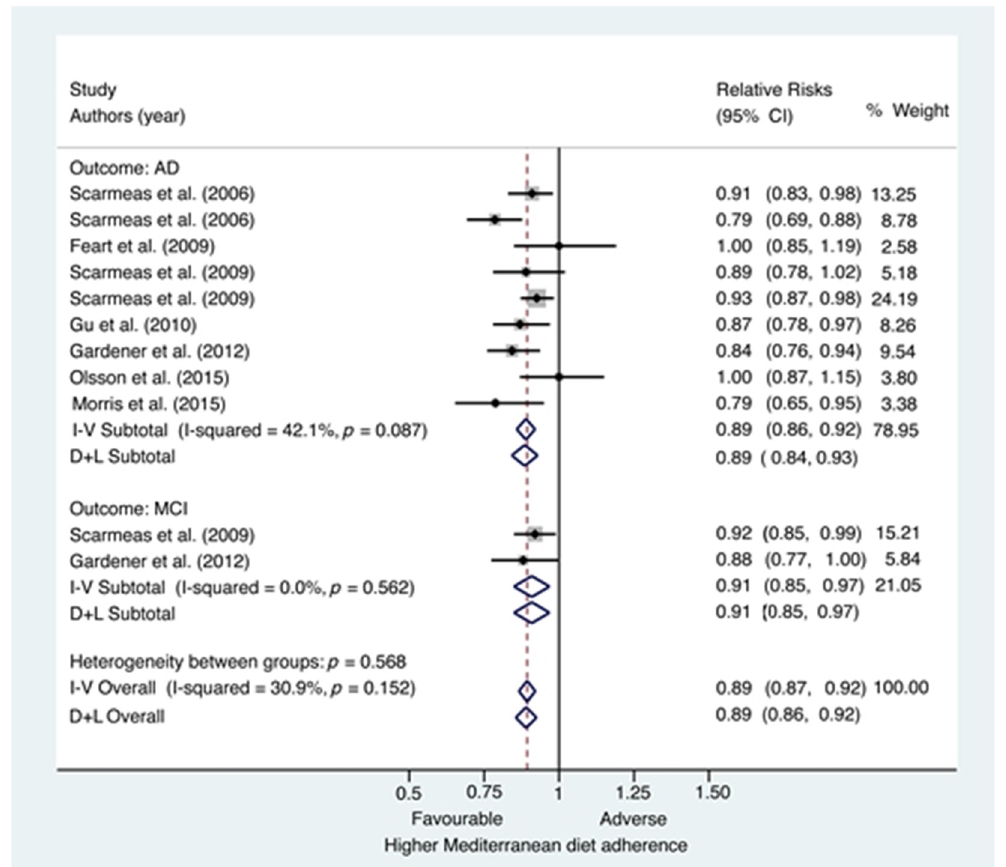
Figure 2. Forest plot of Mediterranean diet adherence and risk of Alzheimer’s disease or mild cognitive impairment. CI = confidence interval; AD= Alzheimer’s disease; I-V= Mantel-Haenszel method (fixed-effects model); D + L = DerSimonian and Laird method (random-effects model); MCI = Mild cognitive impairment.